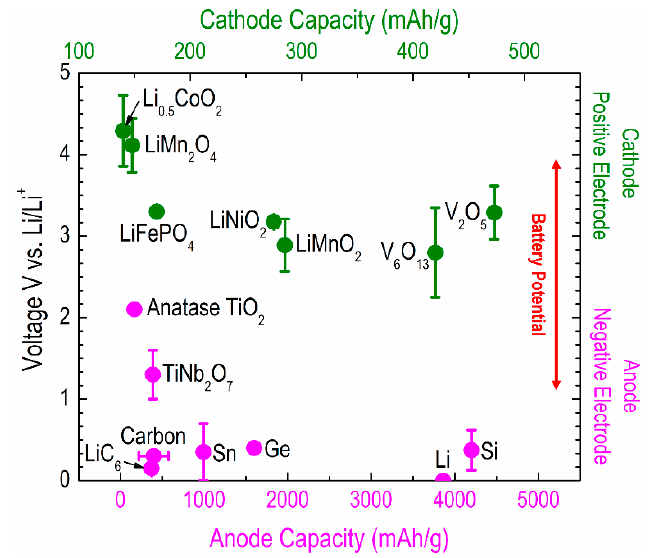
Figure 1. Capacities and voltage windows of various cathode and anode materials [40,41,63–74]. Battery potential is the relative difference between the voltage of the positive electrode and the negative electrode.